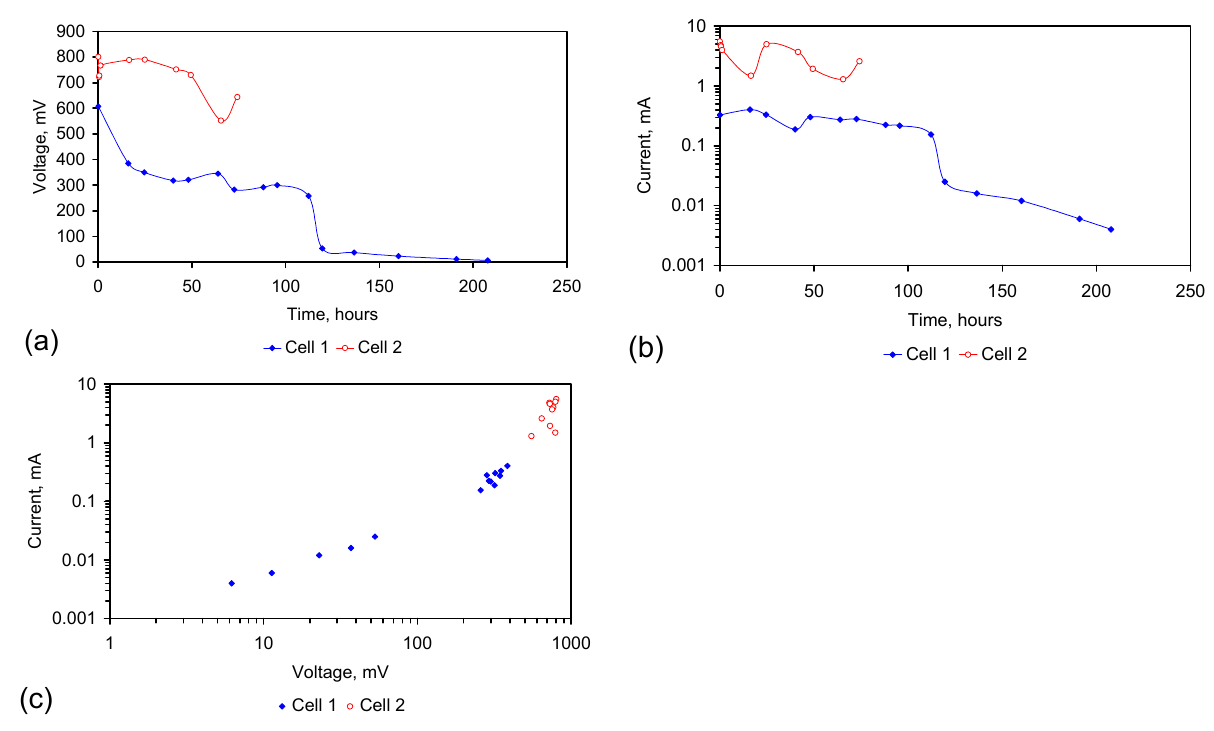
Figure 11. Measured currents and voltages as a function of time, associated with ZVM TP (ST1 to ST5 series) prior to usage for desalination. ( a ) Voltage vs. Time; ( b ) Current vs. Time. ( c ) Current vs.